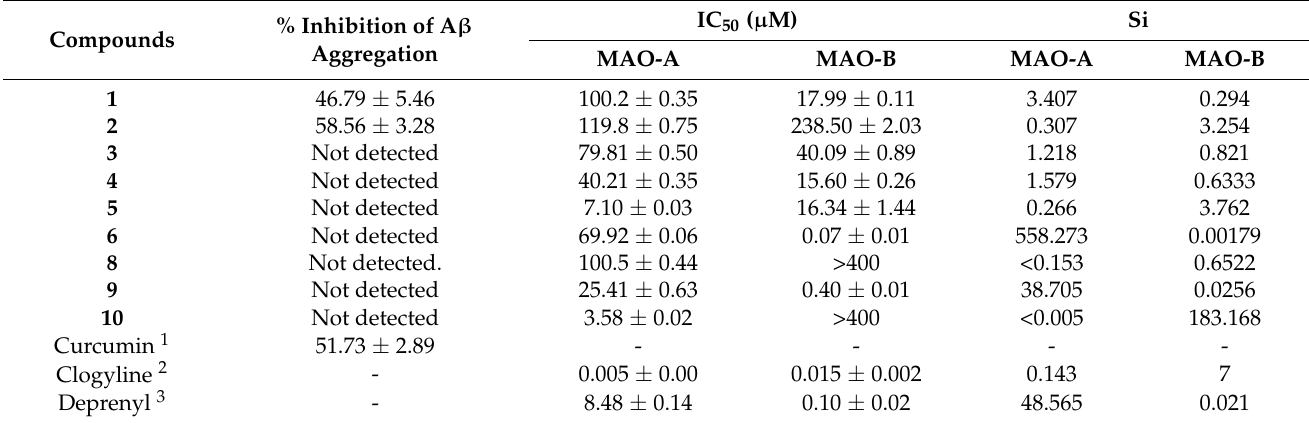
Table 1. Inhibitory effects of 1 – 6 and 8 – 10 on A β self-aggregation and MAOs.